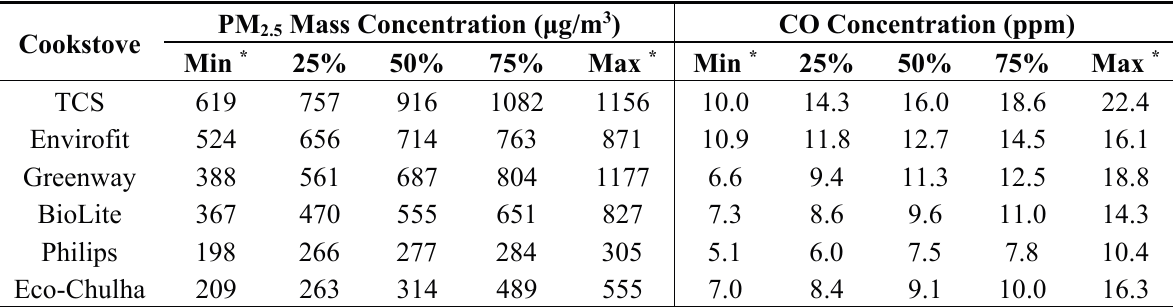
Table 1. Pollutant concentrations from traditional and alternative cookstove use in a real-world test